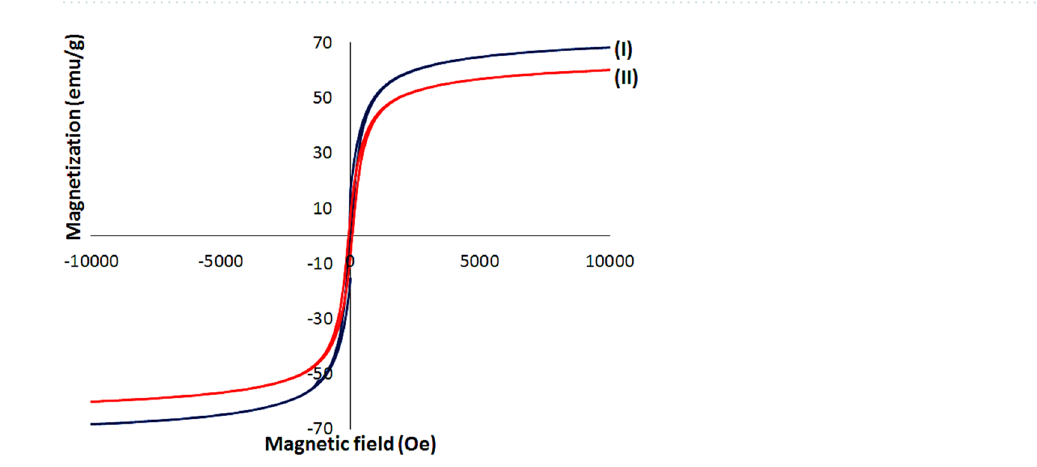
Figure 5. SEM images of ( a ) Fe 3 O 4 @Cur nanopowder, ( b, c ) Fe 3 O 4 @Cur@CPTMS, ( d ) Fe 3 O 4 @Cur/Mel, ( e, f ) Fe